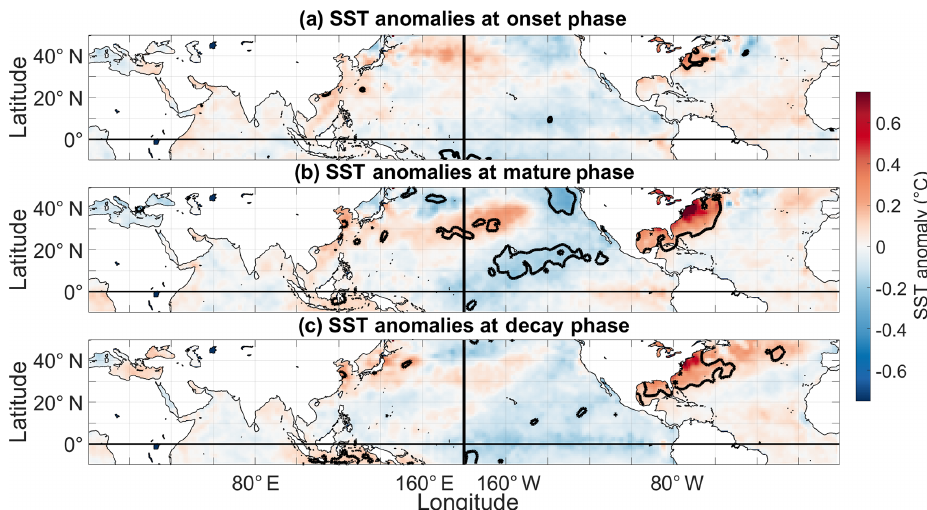
Figure 12. Same as Fig. 10 but for positive LIS temperature